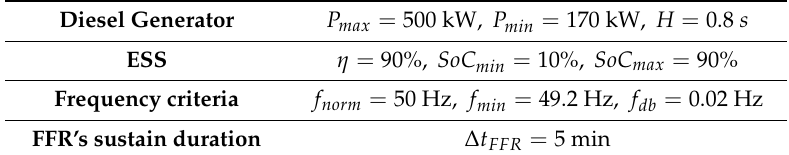
Table 2. Input data.